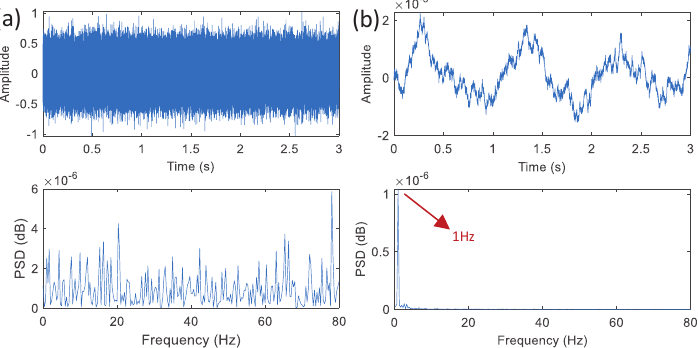
Figure 4. The time domain waveform and power spectral density of the tested signal ( a ) and the synchronization error ( b